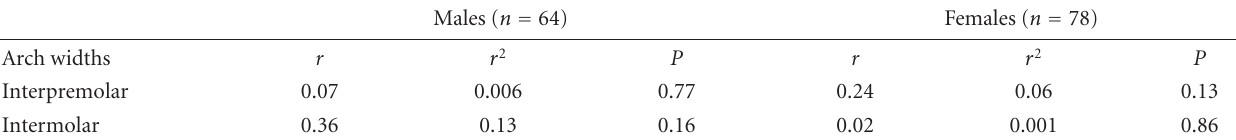
Table 2: Correlation coe ffi cient ( r ) and coe ffi cients of determination ( r 2 ) between measured and calculated arch width values according to Pont’s formulae. Males ( n = 64) Females ( n = 78) Arch widths r r 2 Interpremolar 0.07